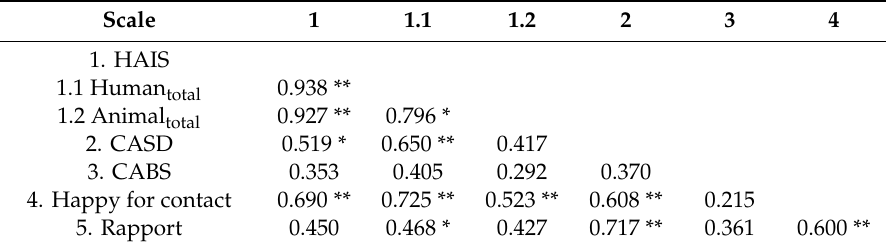
Table 4. Correlations between scales in clinical participants (n = 22).